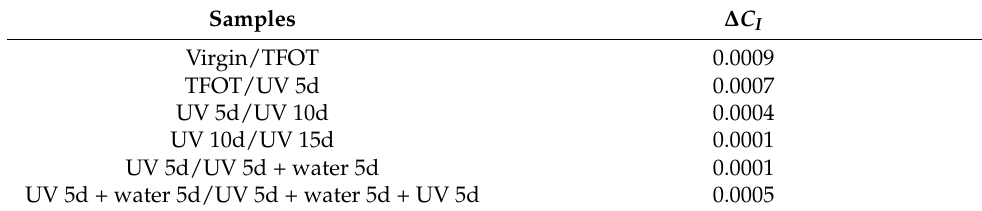
Table 4. Rangeability of C I after the multiple aging.